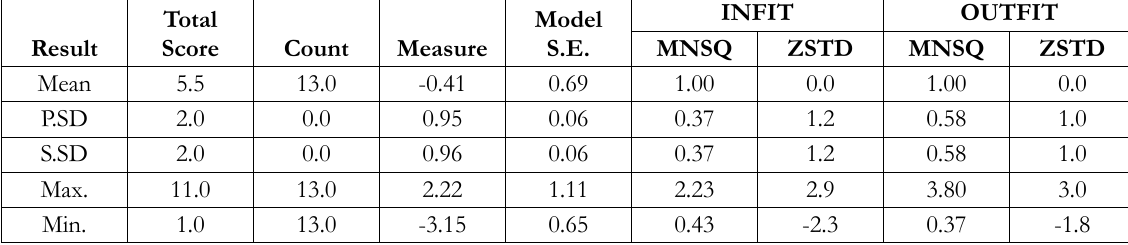
Table 3. Summary of measured